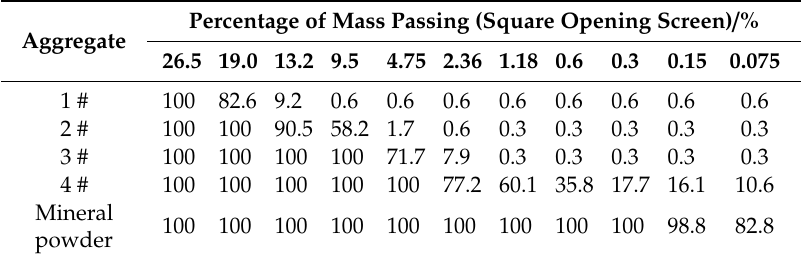
Table 2. Sieving results of the limestone aggregates and mineral powder.